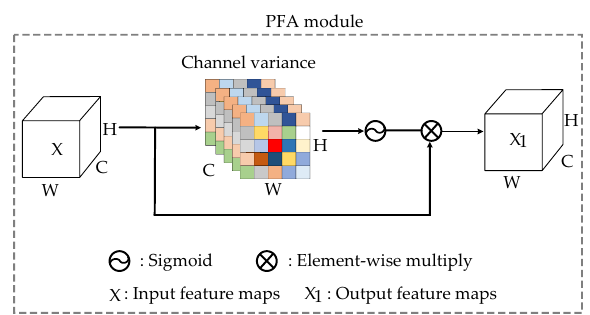
Figure 2. The detail of PFA module. The mean value of input feature maps X and the channel variance are computed to judge the importance of each channel and spatial, so as to generate 3-D weights. Then 3-D weights are processed by the sigmoid activation function and multiplied by X to obtain the output feature maps X 1 . (Created by ‘Microsoft Office Visio 2013’ url: https:// www. micro soft. com/ zh- cn/ micro soft- 365/ previ ous- versi ons/ micro soft- visio- 2013).